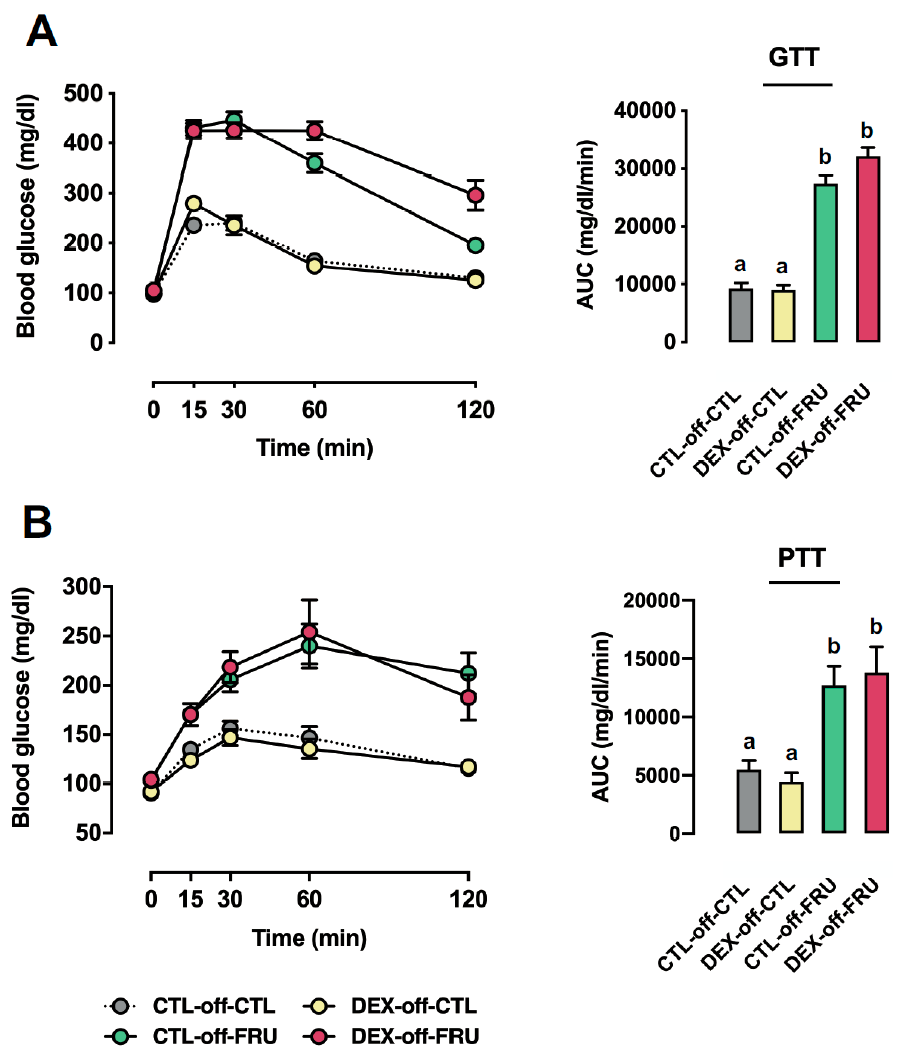
Figure 1. Effects of fructose on glucose homeostasis in rats exposed to dexamethasone (DEX) in utero. CTL-off-CTL, DEX-off-CTL, CTL-off-FRU, and DEX-off-FRU groups were fasted and subjected to either a glucose tolerance test (GTT) (A) or pyruvate tolerance test (PTT) (B) The areas under the curves were calculated above each individual baseline. The results are presented as the mean ± SE. Means with different superscript minuscule letters are significantly different. The p values are provided in Section 3. N = 6 ‒ 8. Area Under the Curve (AUC); Control (CTL); Fructose (FRU).